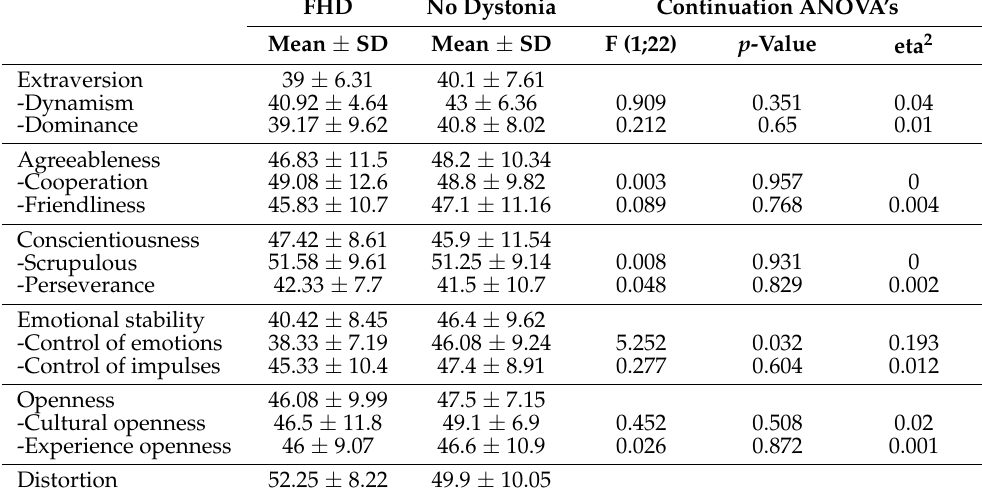
Table 3. Descriptive results and ANOVA